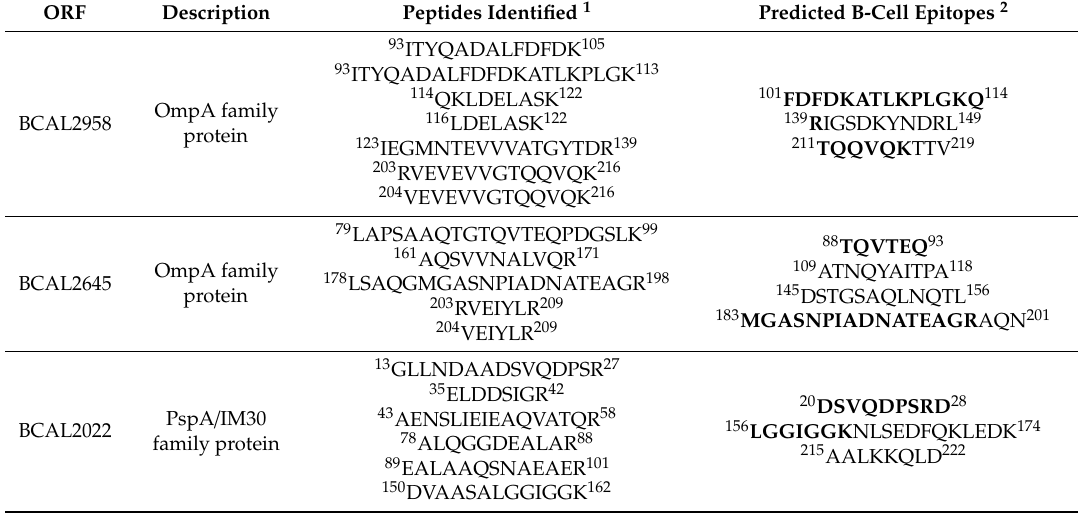
Table 3. Selected surface-associated proteins identified in B. cenocepacia J2315 by using the “surface shaving” strategy followed by LC-MS / MS (threshold score: ≥ 5 peptides) and their predicted B-cell epitopes. The peptides identified by the surface-shaving approach and predicted as B-cell epitopes are shown in